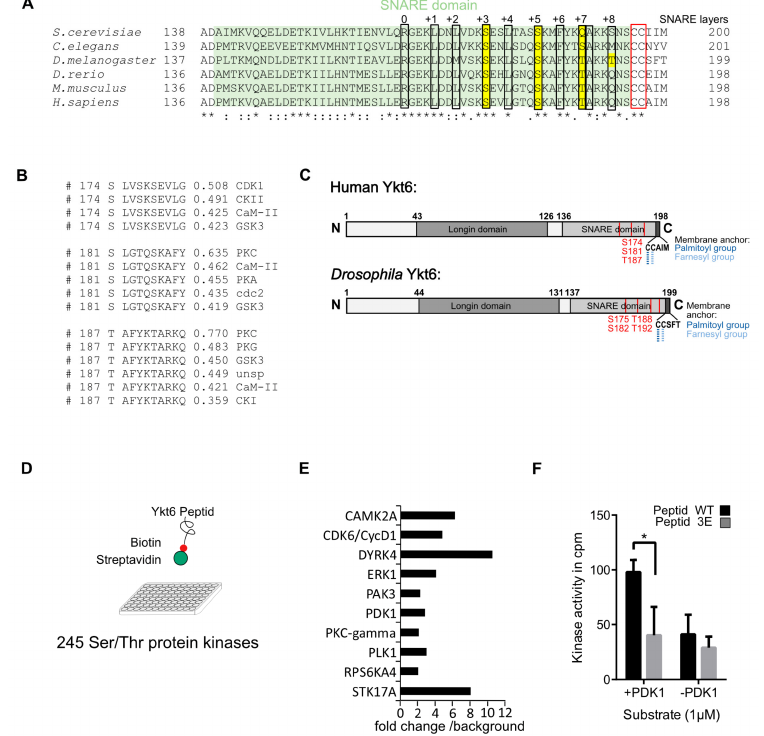
Figure 1. Several phosphorylation sites in the Ykt6 sensitive factor attachment protein receptors (SNARE) domain are evolutionarily conserved. ( A ) Sequence alignment of Ykt6 SNARE domain (Human: position 136–198) of different eukaryotes. Conserved serines and threonines at SNARE layers are marked in yellow, lipid-modified cysteines are in the red box. ( B ) PhosphoSite prediction for human Ykt6 position S174, S181, and T187 using Netphos 3.1 [39]. ( C ) Scheme of human and Drosophila Ykt6 with predicted phosphorylation sites that were either mutated to alanine or glutamic acid. ( D ) In vitro kinase assay of biotinylated peptide of the Ykt6-WT SNARE domain with 245 different serine / threonine kinases. ( E ) Ten out of 18 identified kinases phosphorylating Ykt6 SNARE domain > twofold over background were validated. ( F ) A validation kinase assay comparing Ykt6-WT versus Ykt6-3E found phosphoinositide-dependent kinase-1 (PDK1) as a kinase phosphorylating the SNARE domain. * =